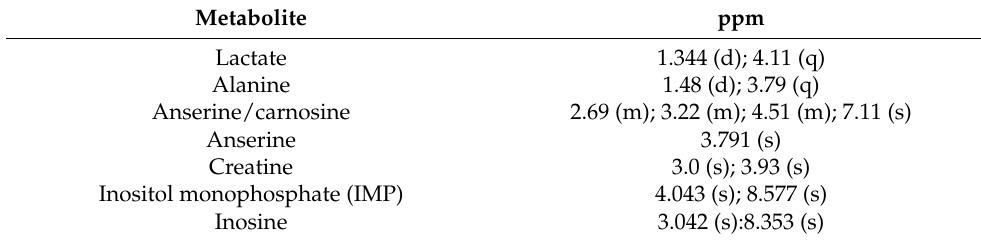
Table 1. Metabolites and their values based on 1 H NMR